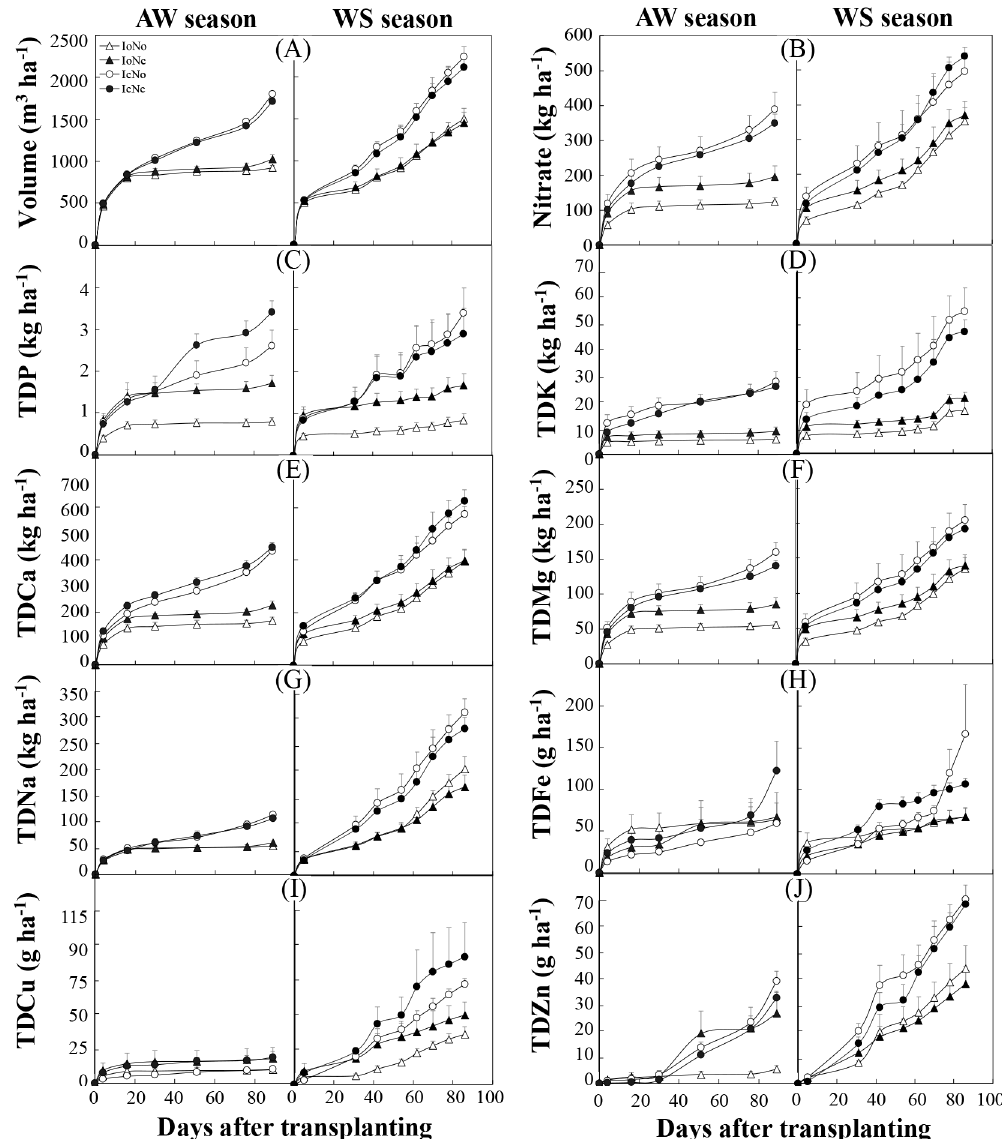
Fig 5. Cumulative leached amounts of water (A), nitrate (B) and total dissolved (TD) mineral elements (B-J) in leaching water under different treatments in the autumn-winter (AW) and winter-spring (WS) seasons. Treatments codes are the same as in Table 1. Bars represent standard errors (n =